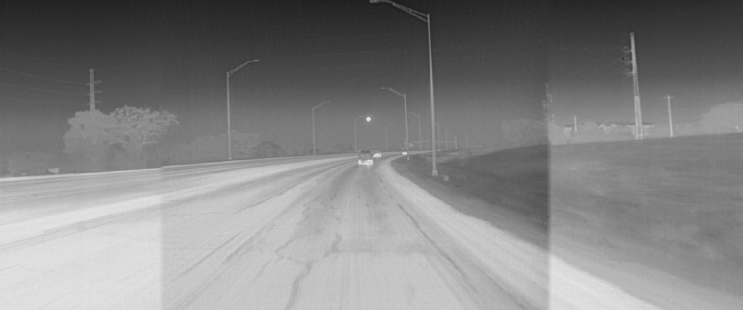
Figure 2. Thermal cameras are resilient to direct sunlight. Showing the same scene as in Figure 1. Reprinted with permission from earlier conference paper Ref. [11]. ©2021, SAE International.